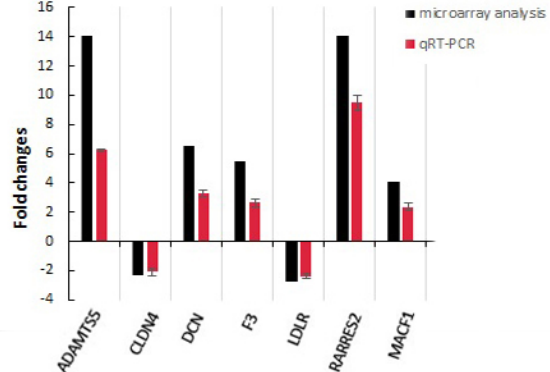
Figure 5. Verification of the microarray results by qRT-PCR. The X-axis shows the seven genes, and the Y-axis represents the fold changes of each transcript. The black bar represents the results of the microarray analysis, and the red bar represents the outcomes of the qRT-PCR. The results of the qRT-PCR are the mean standard deviations (±SD) of at least three